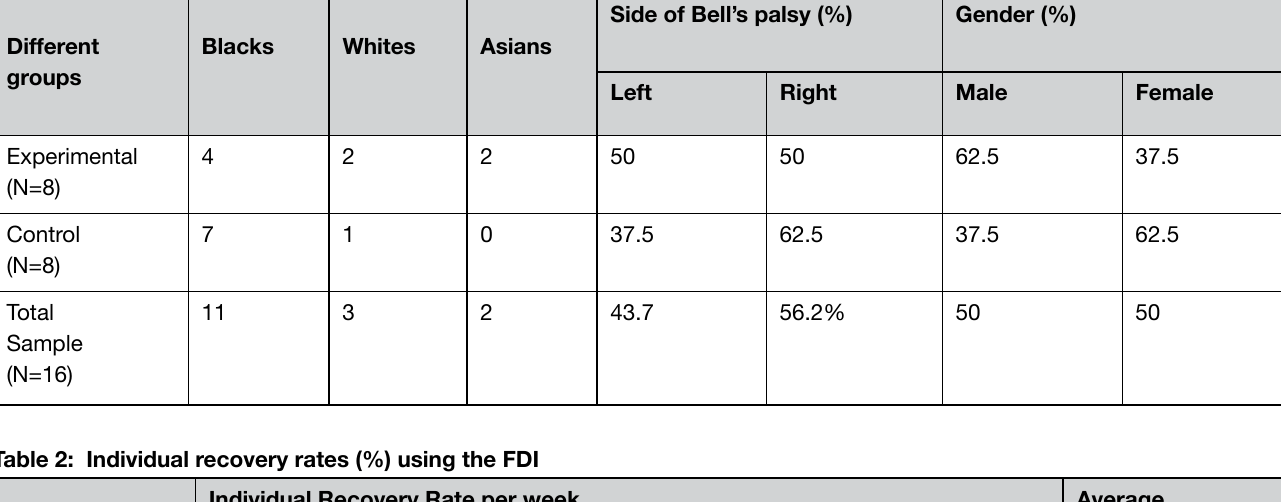
Side of Bell’s palsy (%) Gender (%) left Right Male